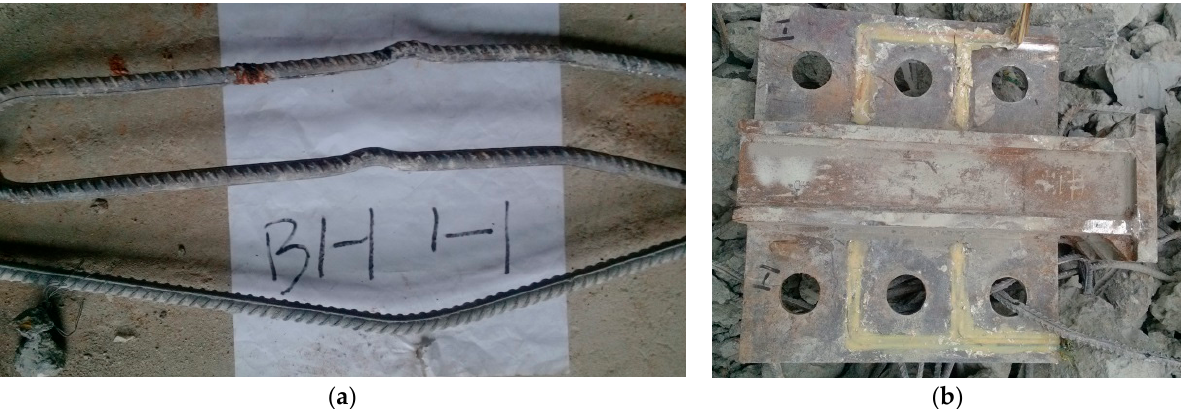
Figure 7. Rib plate and reinforcement of the BH 1-1 specimen after the test: ( a ) Deformation form of reinforcement; ( b ) Deformation form of rib plate